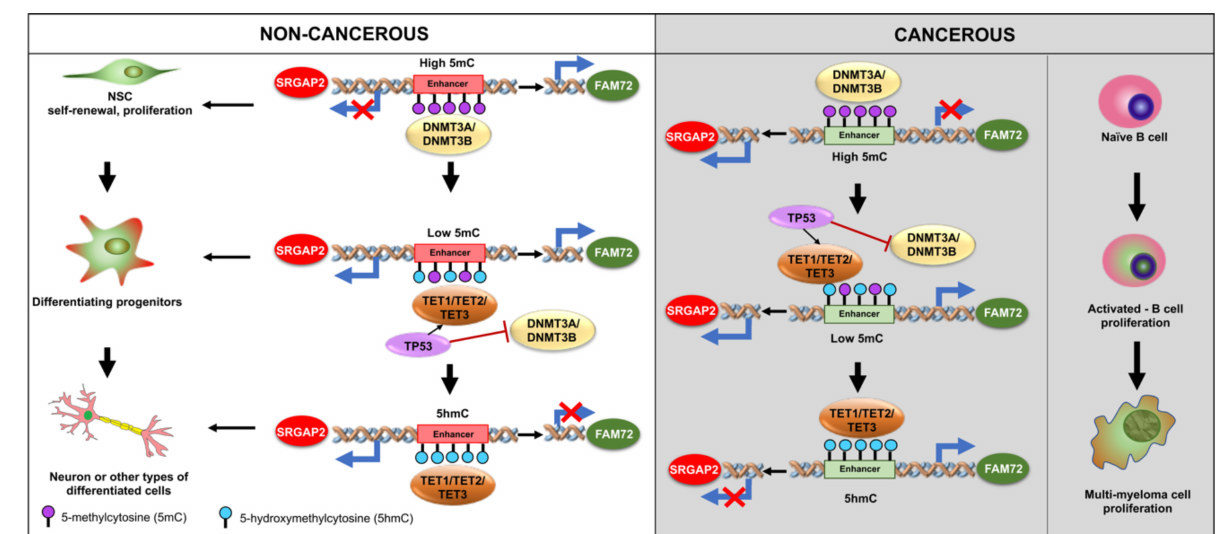
Figure 9. Effects of methylation and demethylation on the expression of the master gene |-SRGAP2–FAM72-|. The epigenetic modifications during neurogenesis can control FAM72 expression for cell fate decision. Dysregulation causes CSC formation and tumorigenesis. In proliferating (non-cancerous) NSCs, demethylation or hypomethylation (such as 5-hydroxymethylcytosine (5hmC) or the loss of the methyl group in the 5-methylcytosine nucleotide (5mC)), were demonstrated to activate neurogenic genes such as SRGAP2 to mediate neural differentiation [142]. As a consequence, FAM72 is deactivated. In cancer, demethylation is crucial for FAM72 activation during CSC proliferation. In the case of glioma genesis, FAM72 is silenced in glia progenitor cells until activated TP53 replaces the methylation factors DNA methyltransferase 3 alpha/beta (DNMT3A/DNMT3B) for demethylation factors TET1/TET2/TET3 so that FAM72 is activated for proliferation and forming GBM cells, which is in line with the genomic hypomethylation of the FAM72 promoter region in our previous study (Figure 8) [12,149,150]. FAM72 expression is activated outside the CNS only under cancerous conditions by mutated protooncogenes and genomic FAM72 demethylation by TET family members to support the proliferation of cancerous cells including multiple myeloma